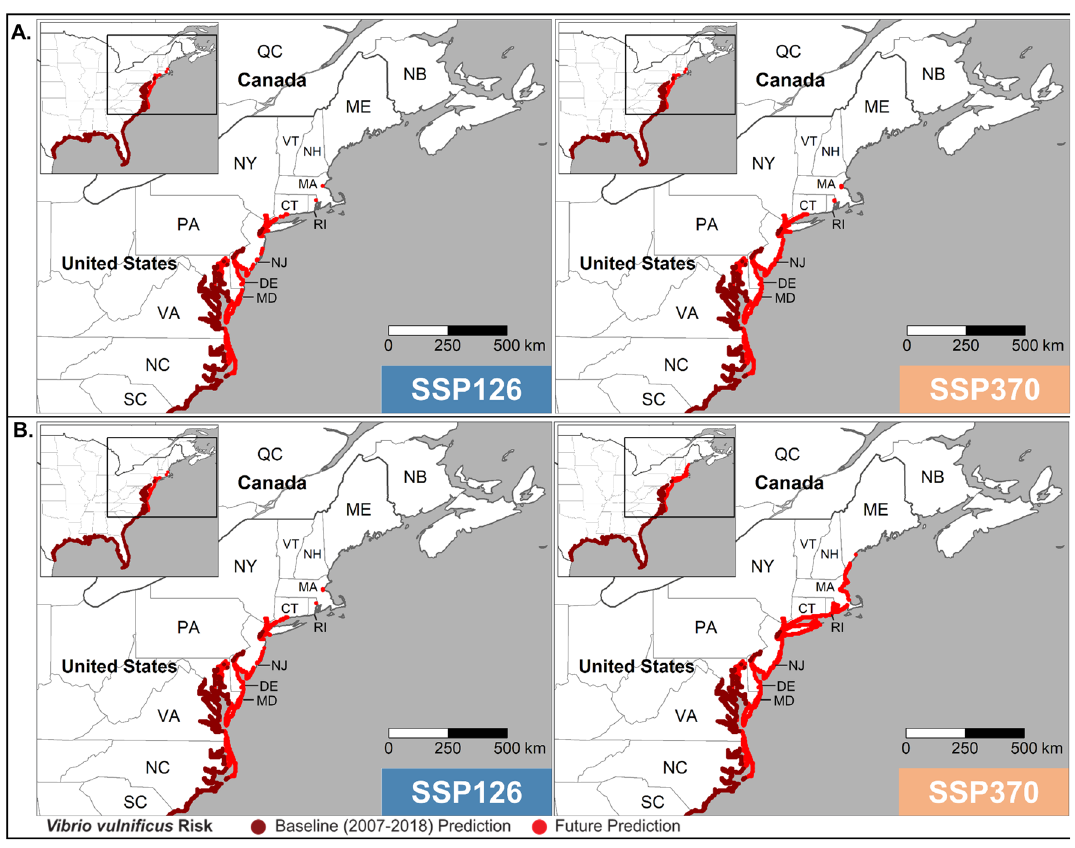
Figure 4. As Fig. 3 but predicted using